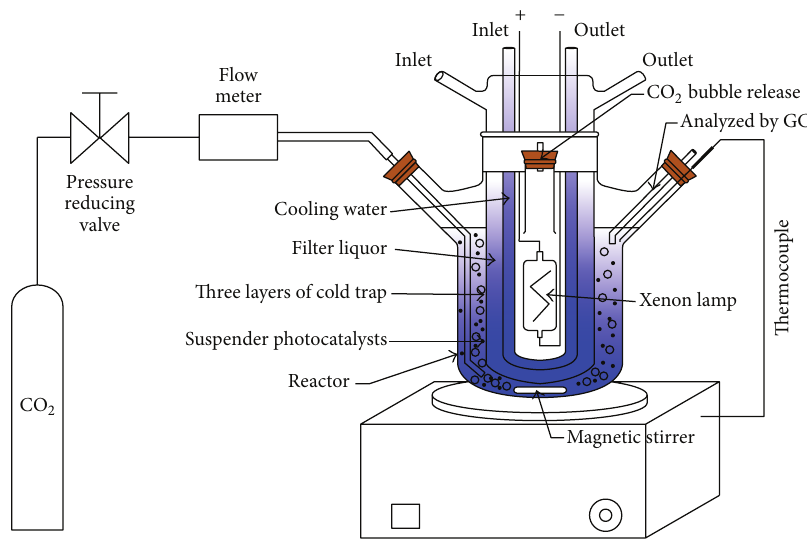
Figure 1: Schematic view of reactor system for photocatalytic reduction of carbon dioxide.